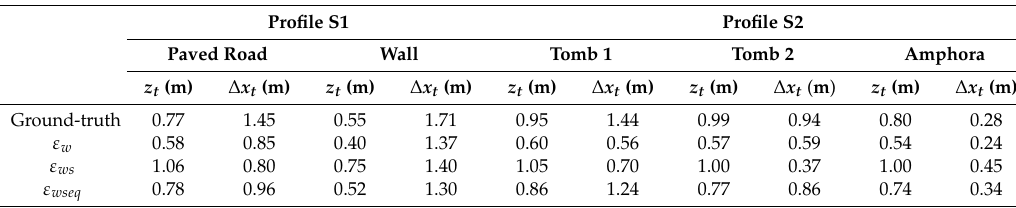
Table 2. Values of the all buried objects for both considered profiles in terms of upper side location (depth z t (m)) and horizontal size ( ∆ x t